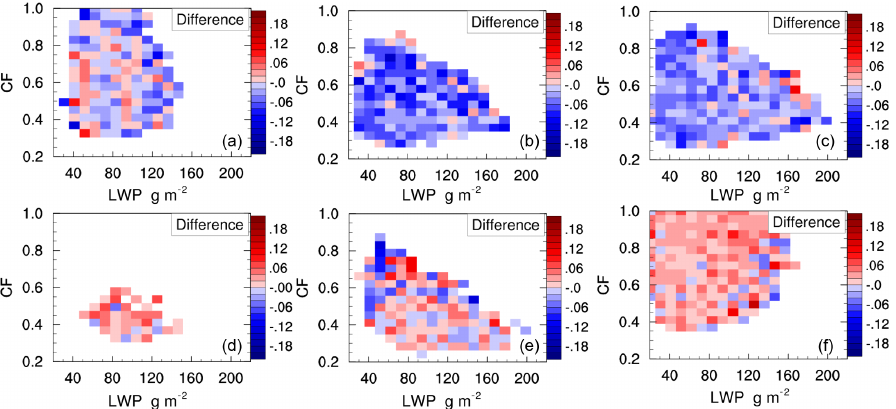
Figure 4. The difference of TOA albedo for the polluted (AOD/AI > 75th percentile) and clean cases (AOD/AI < 25th percentile) ( (cid:49)α ) over (a) EC, (b) EU, (c) WE, (d) ECO, (e) EUO, and (f) WEO, in which data are stratified according to both LWP ( x axis) and CF ( y